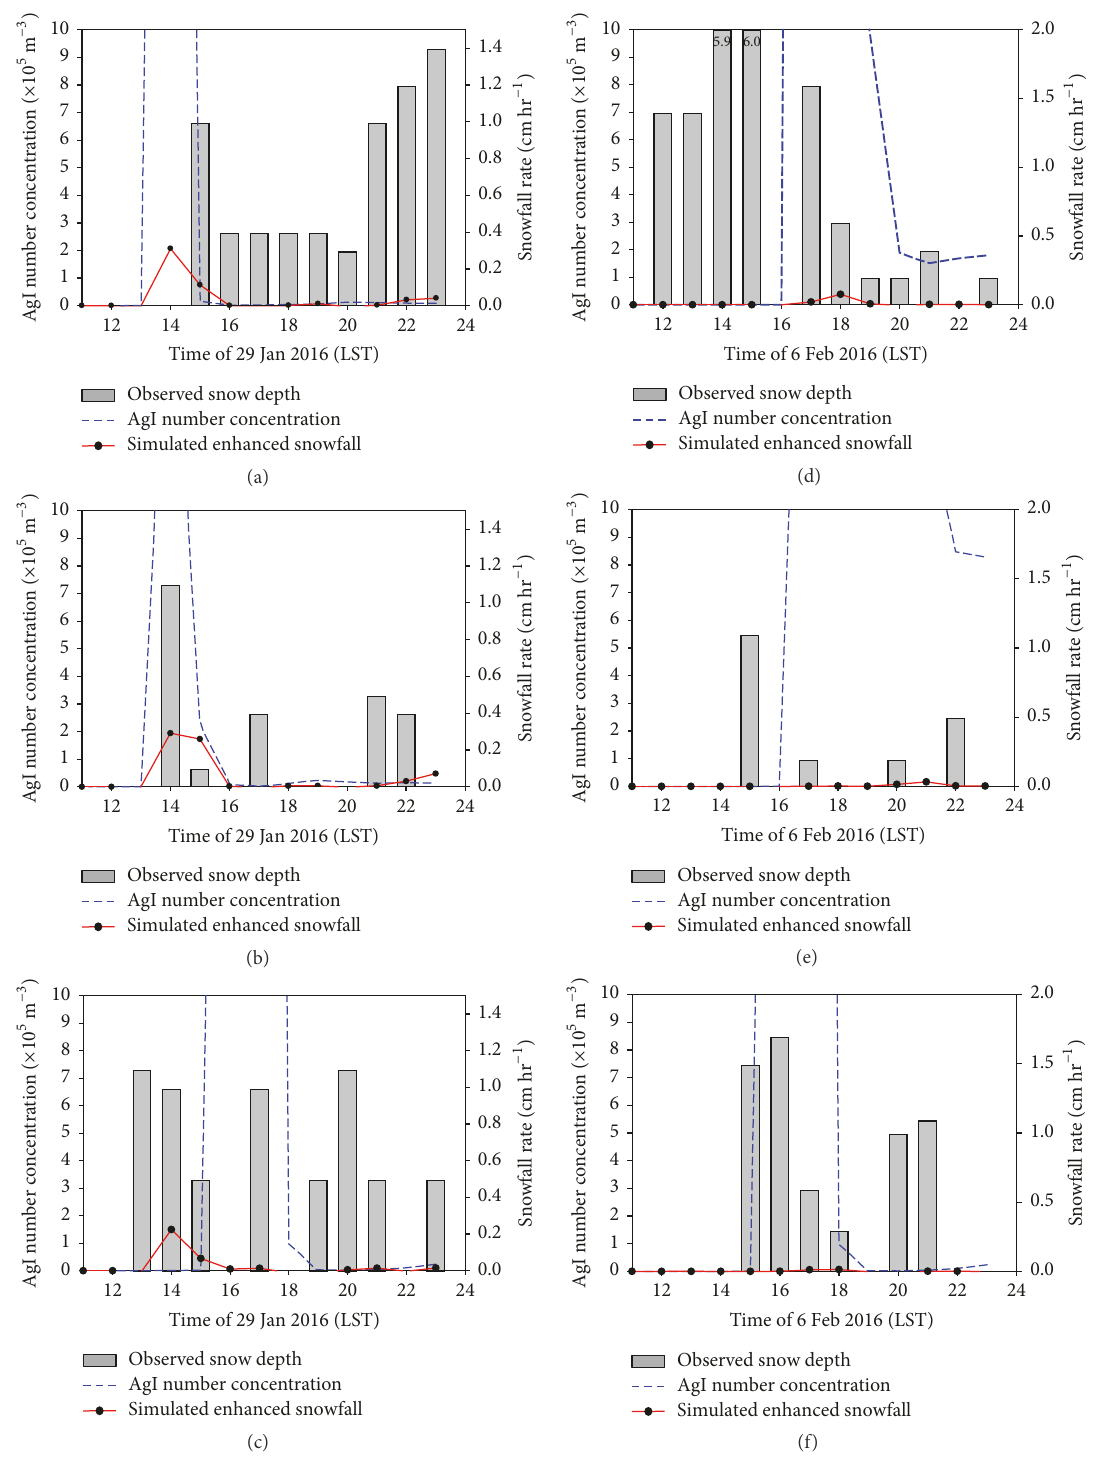
Figure 9: The hourly simulated (SEED-NOSEED; dot-solid) and observed (bar) snowfall by snow-depth meter in EXP1 ((a) CPOS, (b) YP, and (c) OD) and EXP2 ((d) CPOS, (e) YP, and (f) OD). The dashed lines denote the hourly simulated AgI concentration. All the simulated values were calculated in each 10km × 10km box centered at the observation